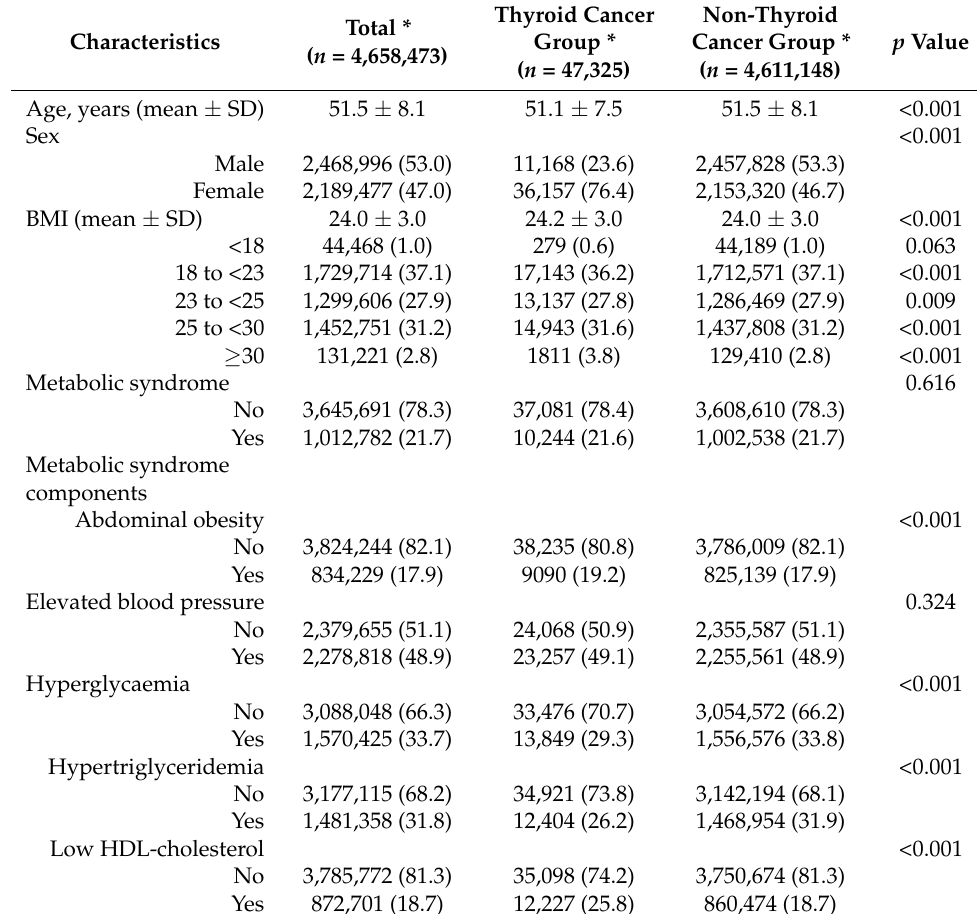
Table 1. Baseline characteristics of the study